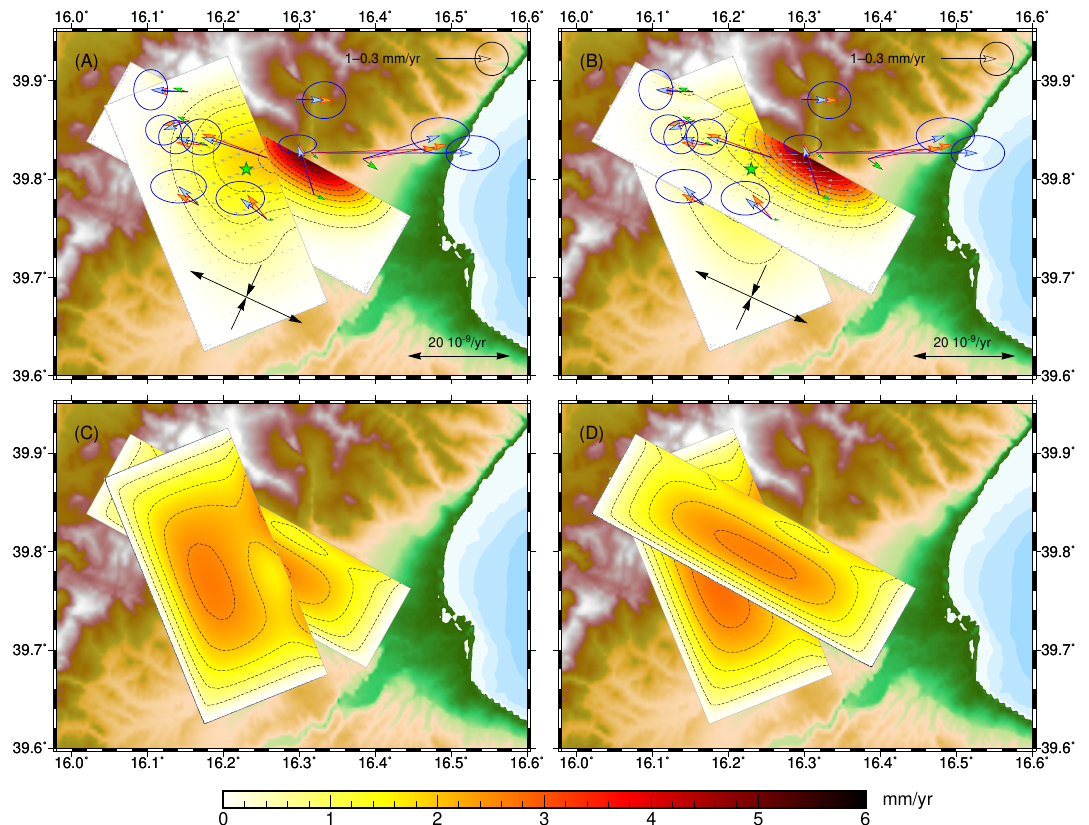
Figure 4. ( A , B ) Mean fault creep distributions and ( C , D ) standard deviation over the Castrovillari and Pollino faults (the left and right columns show the Castrovillari fault over the Pollino one and viceversa), estimated according to the inversion scheme FR (see Table 3). The gray arrows represent the direction of the fault creep and the contour lines are given every 0.5mm/yr. In panels A and B, the blue and red arrows are the observed and modelled surface velocities, after the removal of the estimated rigid-body motion. The ellipses represents the one-sigma errors from GNSS data analysis (observational error) and should be rescaled by the square root of the estimated hyper-parameter α √ α = 1.05 for this inversion). The estimated regional in order to account for the modelling errors ( strain rate is also drawn, further south with respect to the reference point ( φ 0 , θ 0 ) of the Taylor series expansion (green star), and the green arrows represent the velocities due to this strain